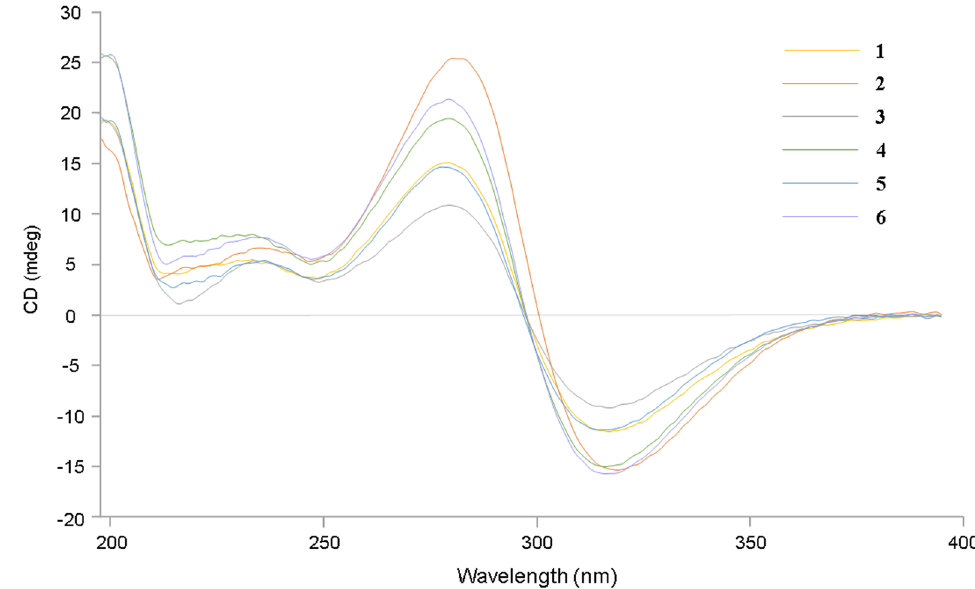
Fig. 5 CD spectra for walsurobustones A‑E ( 1 – 5 ) and Toonapubesic acid B ( 6 ) (in MeOH)